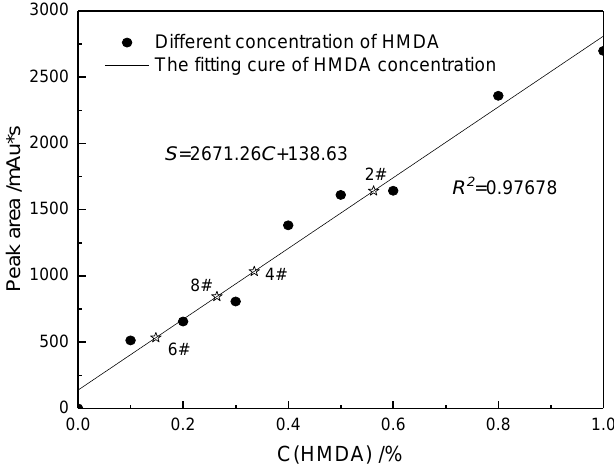
Figure 5. The residual HMDA concentrations of drilling fluids after passing through mud cakes.